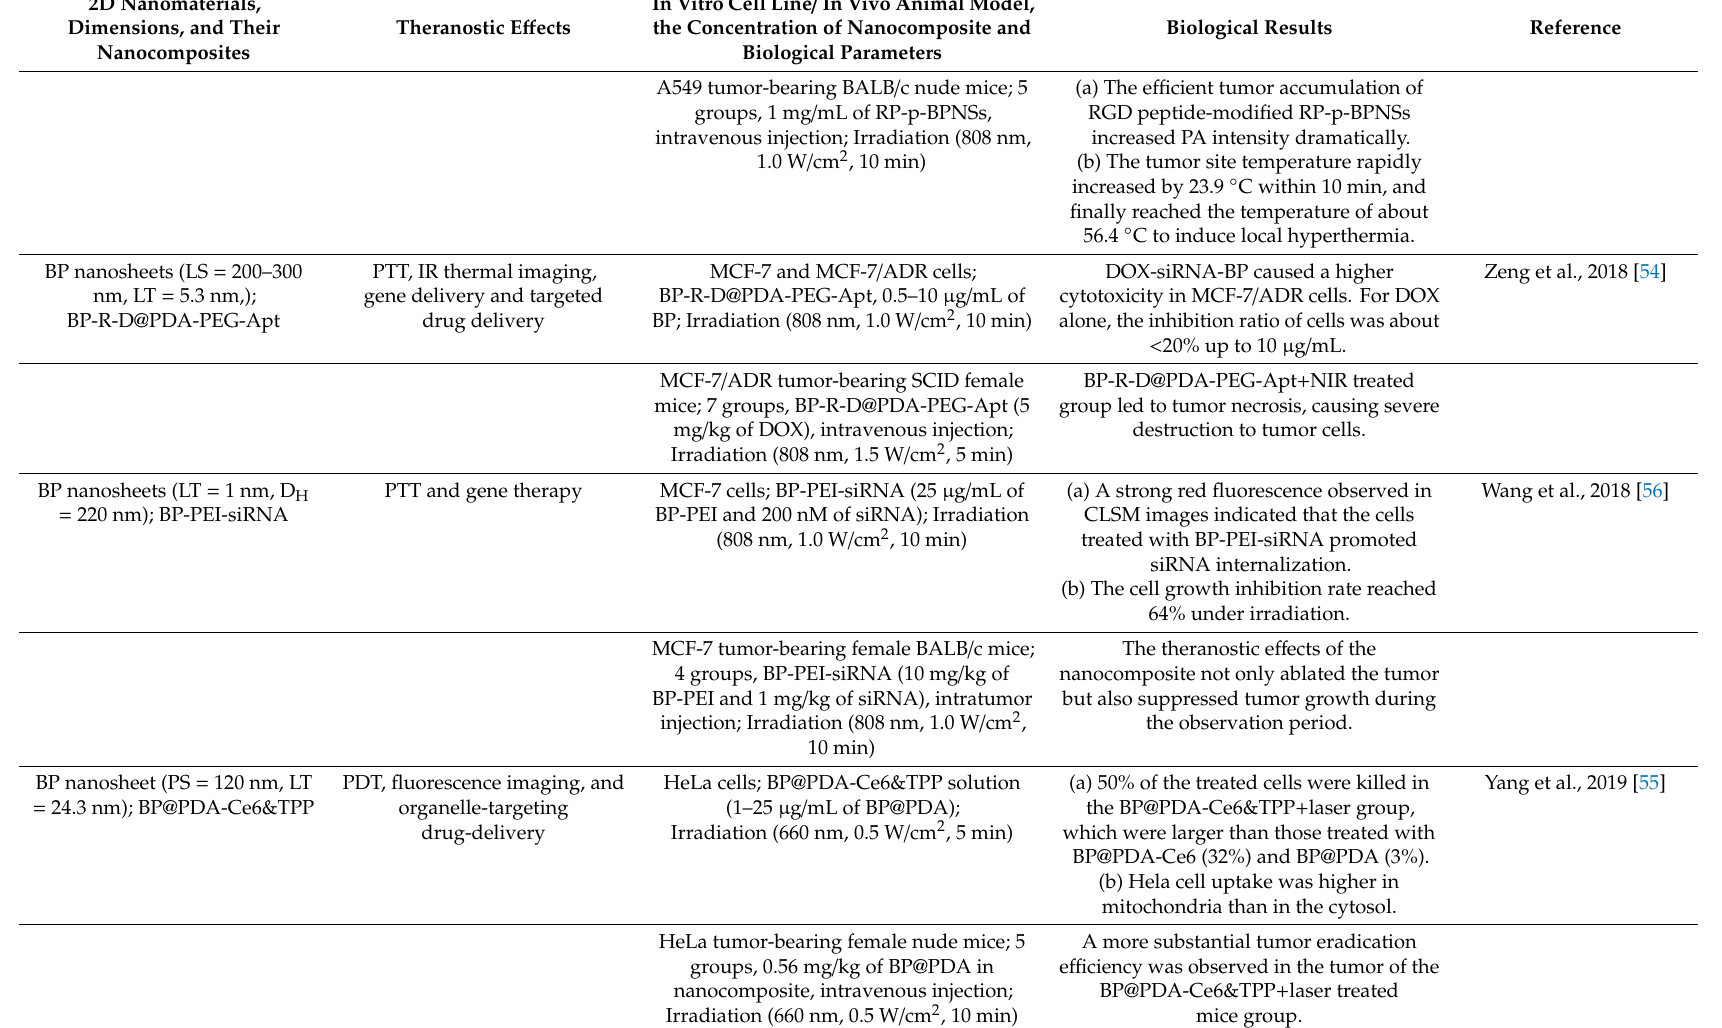
Biological Results Reference